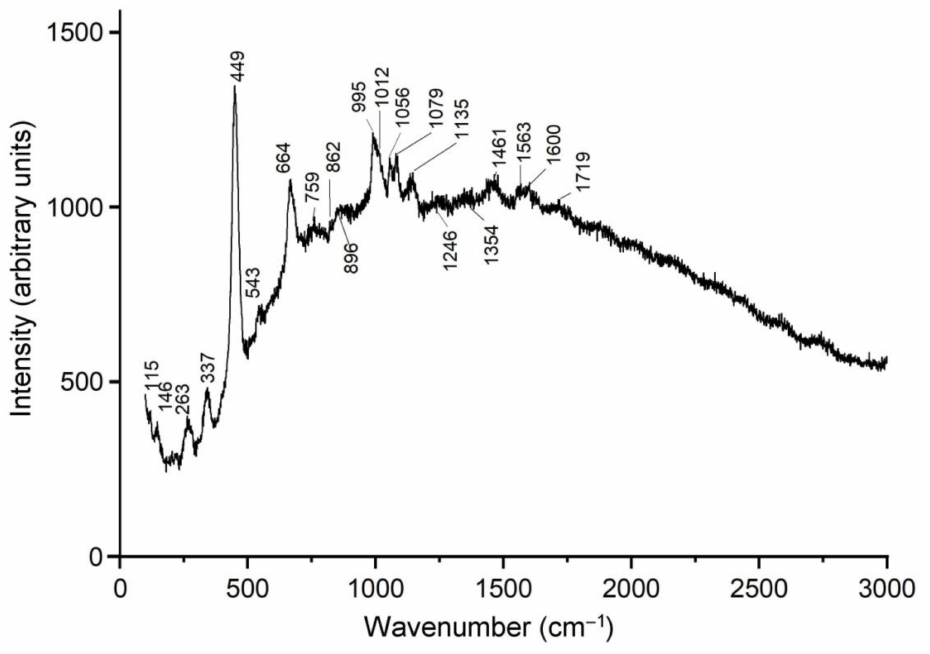
Figure 31. Raman spectrum of the product of Experiment